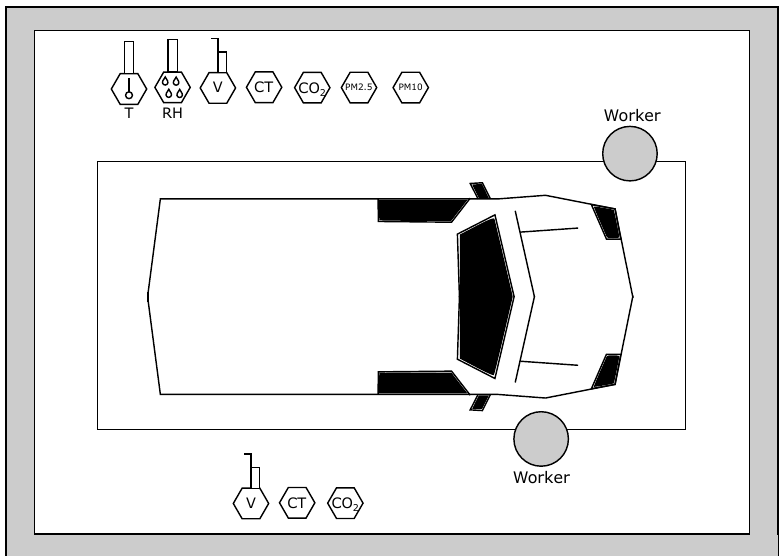
Figure 3. Schematic representation of the experimental measurements (V = Air Velocity, CT = Electric Current used for welding, T = Air Temperature, RH = Relative Humidity, CO 2 = Carbon